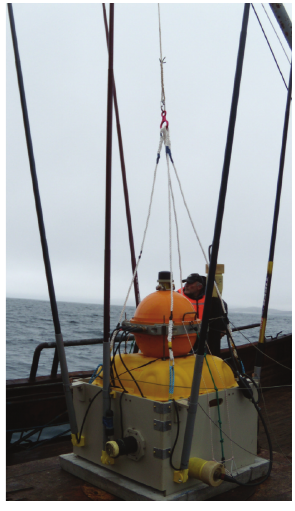
Figure 1: Six-component seafloor receiver before